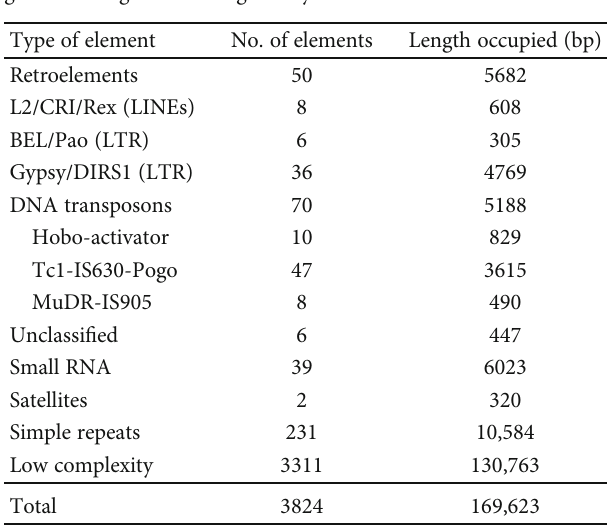
Table 2: Summary of repeats within the reniform nematode genome using the REPLI-g